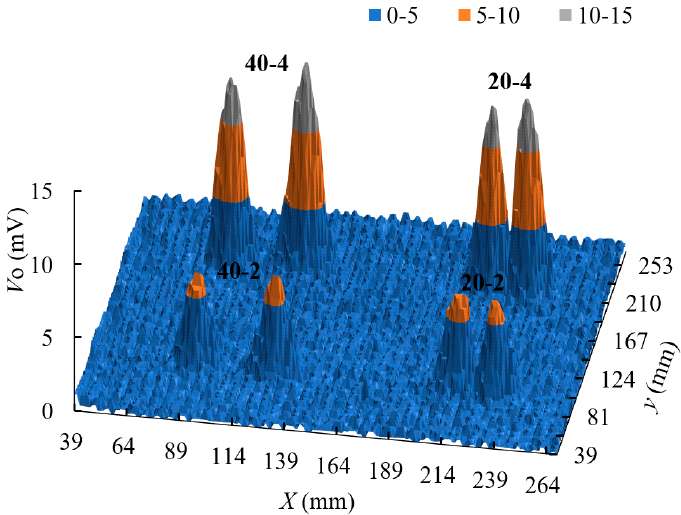
Figure 11. Measurement results of the butterfly probe with scanning 1 in x-y area.